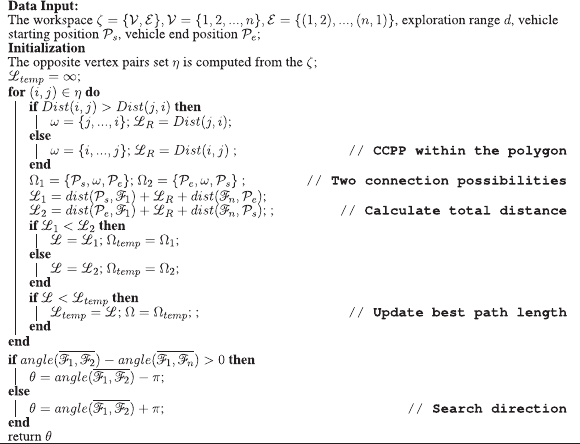
Algorithm 1. Pseudo-code for search